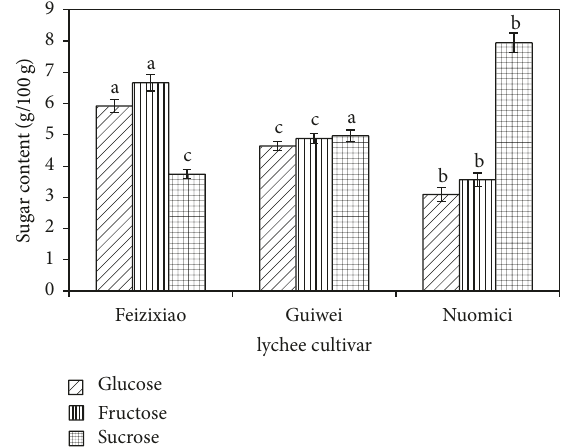
Figure 3: Sugar compositions in three cultivar lychees. ((a), (b), (c)) Values in the same column not sharing the same superscript are significantly different ( 𝑝 < 0.05 ).